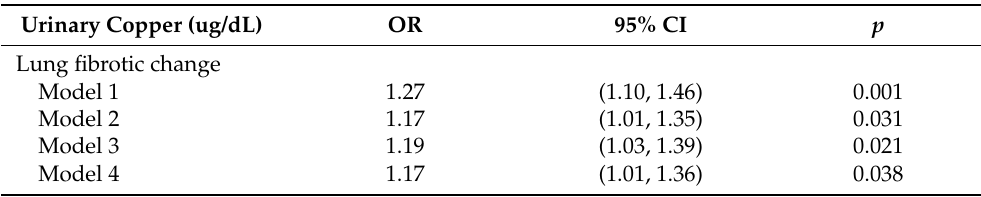
Table 4. Odds ratio (95% Confidence Interval) for lung fibrotic changes associated with a unit increase of urinary copper concentration ( n =